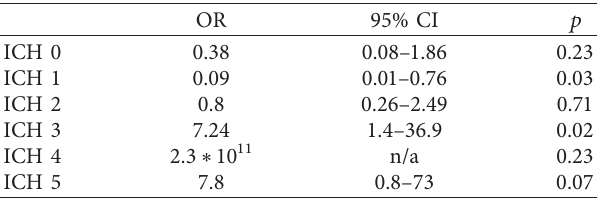
Table 4: Risk of 30-day mortality based on the Intracerebral Haemorrhagic Stroke Score regarding admission day (weekdays vs. weekends and holidays).